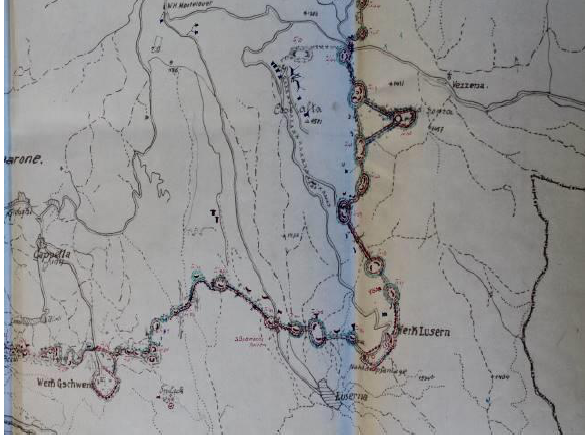
Figure 1 . Vezzena Plateau: militarization projects